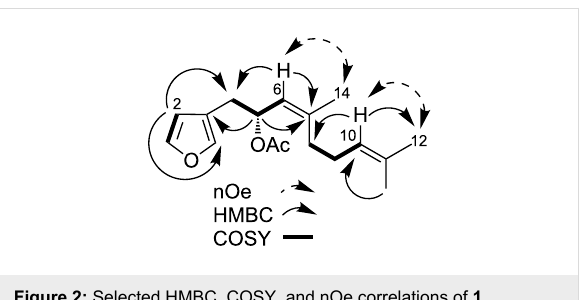
Figure 2: Selected HMBC, COSY, and nOe correlations of 1